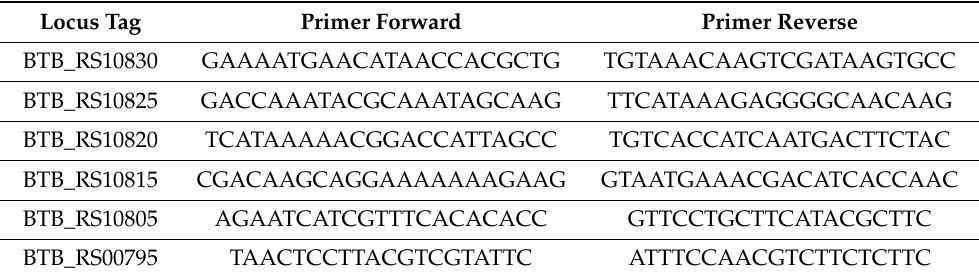
Table 2. List of qPCR primers used in this study.